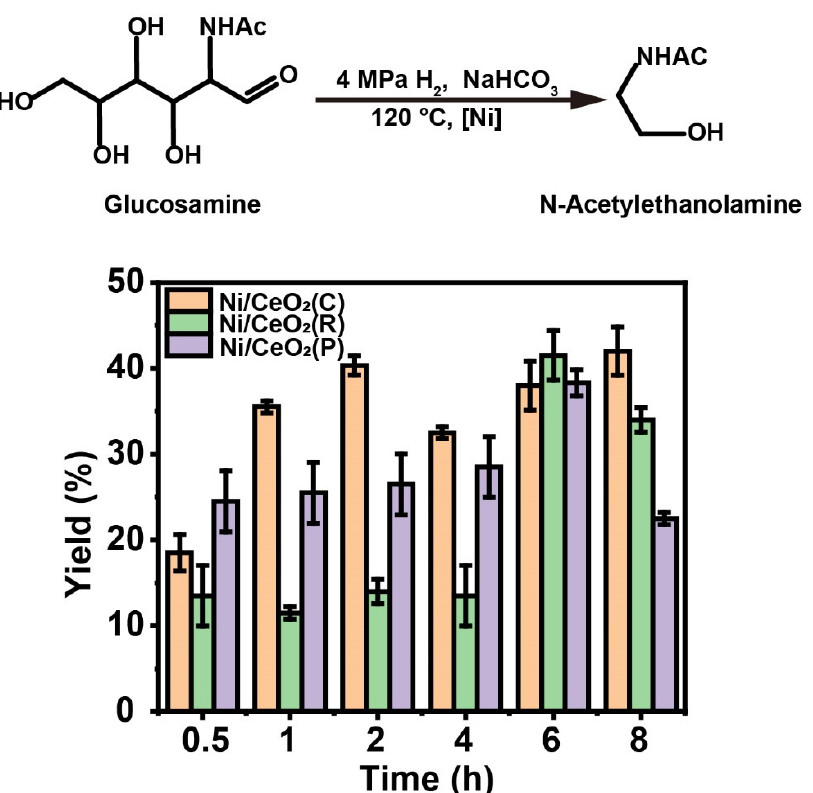
Figure 6. Time-monitored degradation of NAG to N -acetylethanolamine over Ni/CeO 2 (C), Ni/CeO 2 (R), and Ni/CeO 2 (P) catalysts. All data in this ‘yield versus time’ graph were generated at 120 °C temperature and 4 MPa H 2 pressure. All errors are <5%.